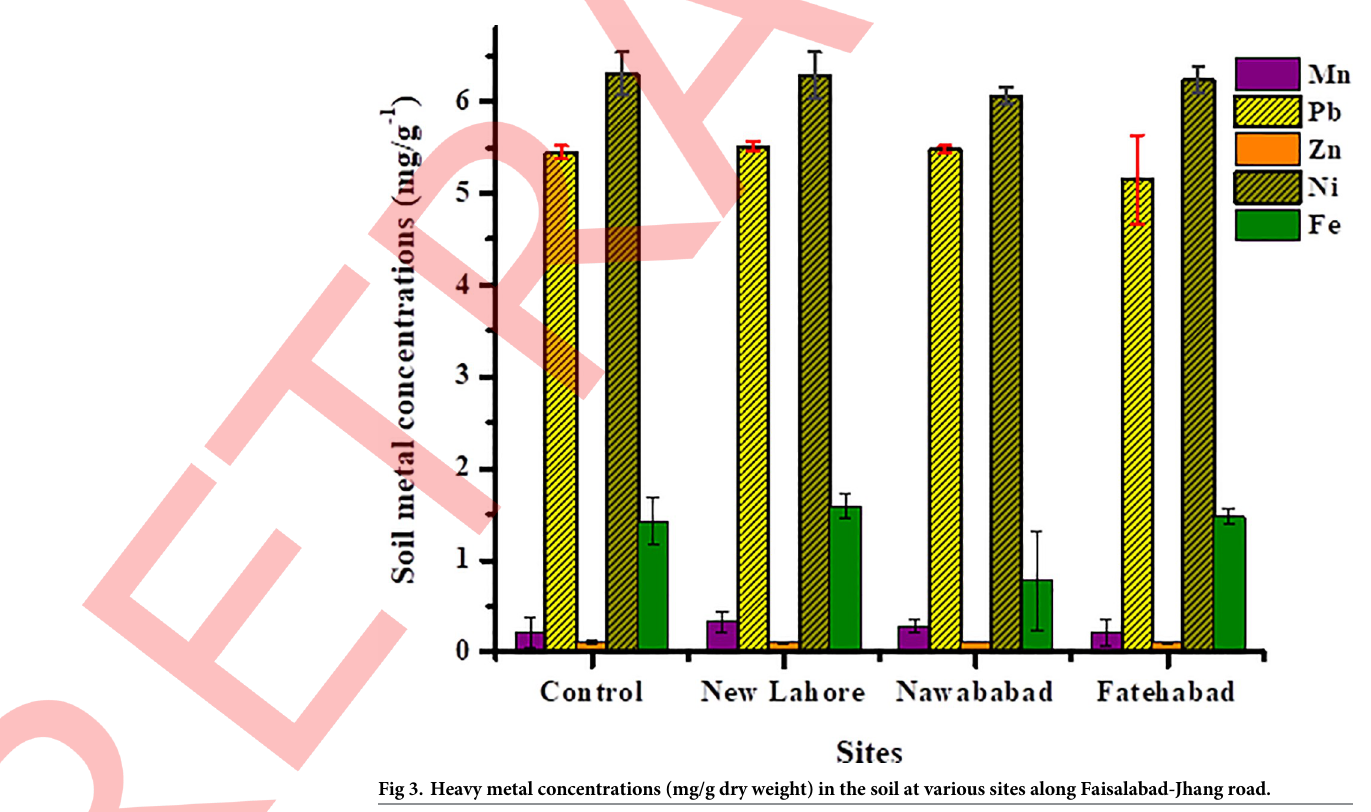
Fig 3. Heavy metal concentrations (mg/g dry weight) in the soil at various sites along Faisalabad-Jhang road.